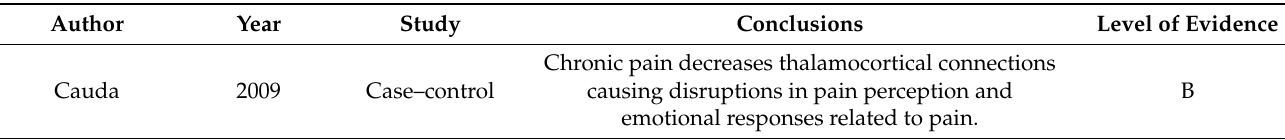
Table 3. Summary of findings from included studies suggesting fMRI is effective at detecting painful diabetic